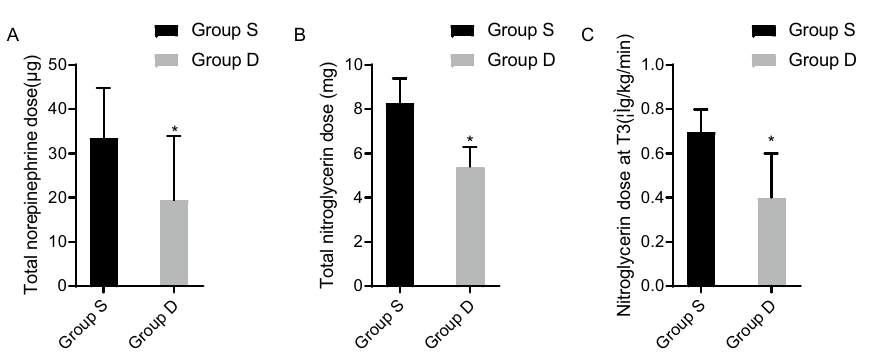
Figure 2. The use of vasoactive drugs in the two patient groups. Compared with the D group, the total dose of norepinephrine and nitroglycerin used in the S group was larger, and the difference was statistically significant (* P < 0.05). The dose of nitroglycerin used in group S at T3 was higher than that in group D, and the difference was statistically significant ( P < 0.05).